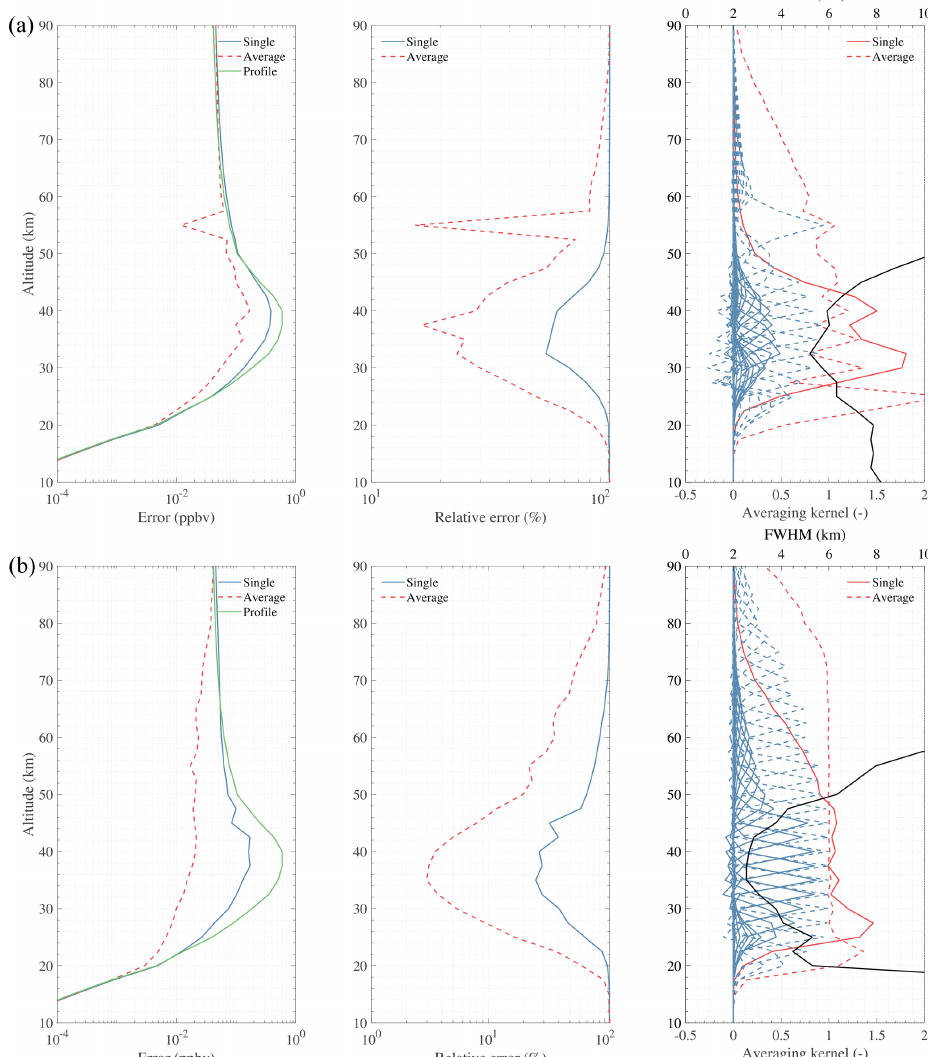
Figure 18. Simulation results of ClO retrieval using 203.4 (a) and 649.45GHz (b) lines. “Single” and “Average” represent the retrieval error using different noise. “Profile” represents the typical profile used in the simulation. The black solid line in the last panel represents the FWHM (i.e. vertical